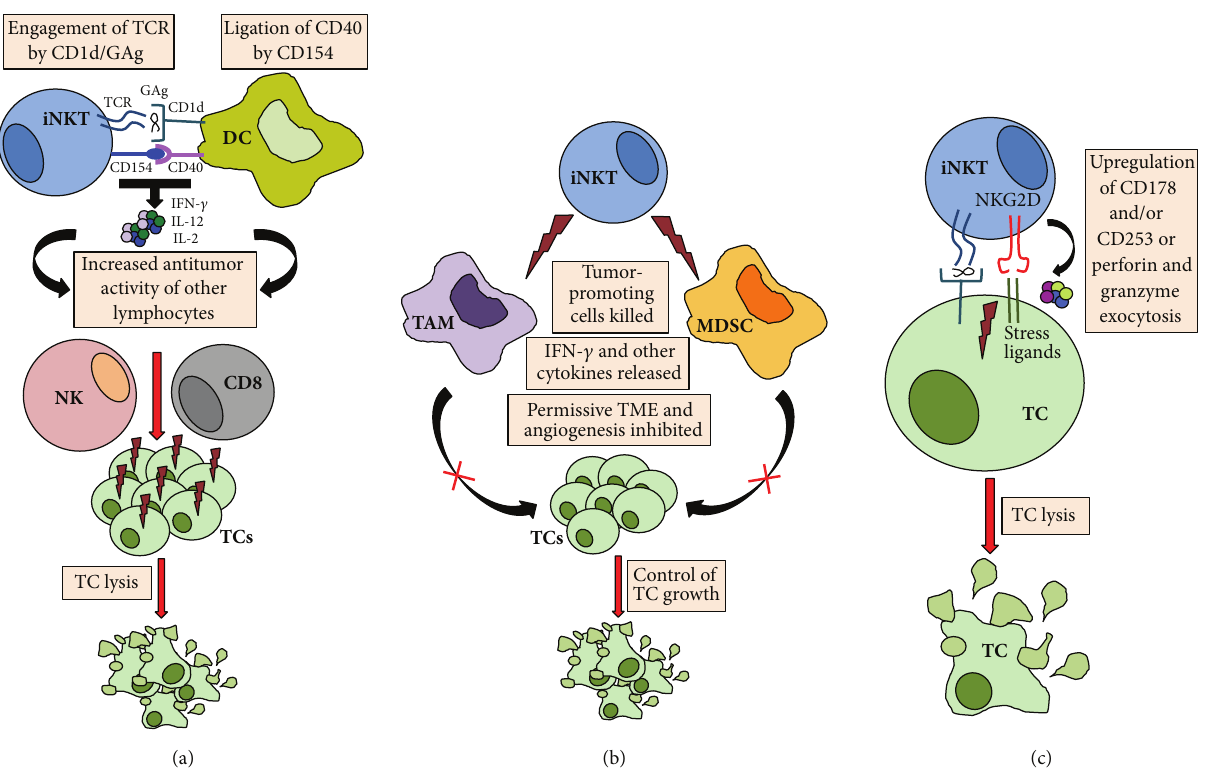
Figure 1: Possible mechanisms of iNKT cell-mediated antitumor responses. (a) Indirect cytotoxicity. iNKT cells and DCs reciprocally coactivate each other via TCR:CD1d/GAg and CD40:CD154 interactions, resulting in the release of several cytokines that secondarily activate and promote the antitumor cytotoxicity of other effector lymphocytes. (b) Modulation of the TME. iNKT cells kill tumor-supporting cells, such as TAMs and MDSCs, and also limit angiogenesis, to indirectly control tumor growth. (c) Direct cytotoxicity. iNKT cells mediate lysis of tumor targets via engagement of TCR or NKG2D. Lightning bolt: exertion of direct cytotoxicity; DC: dendritic cell; GAg: glycolipid antigen; TC: tumor cell; TAM: tumor-associated macrophage; MDSC: myeloid-derived suppressor cell; TME: tumor